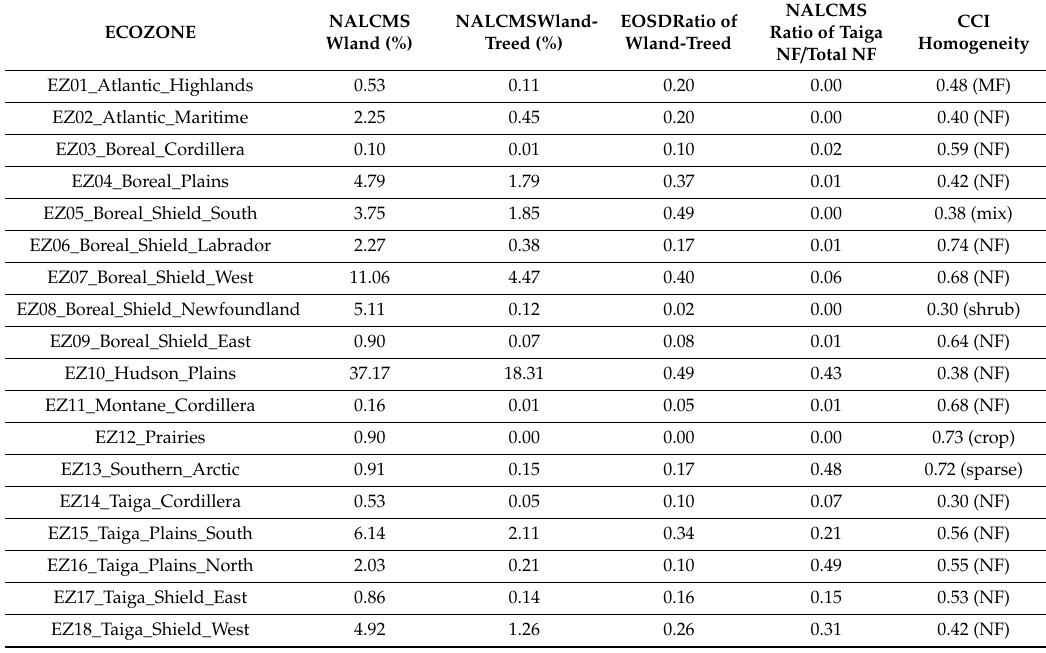
Table 2. Percentage of wetland (Wland) and Wland-treed (based on ratio from EOSD) from NALCMS, ratio of taiga needleleaf vs. total needleleaf in NALCMS, and homogeneity in CCI (brackets show cover type) in 18 ecozones across